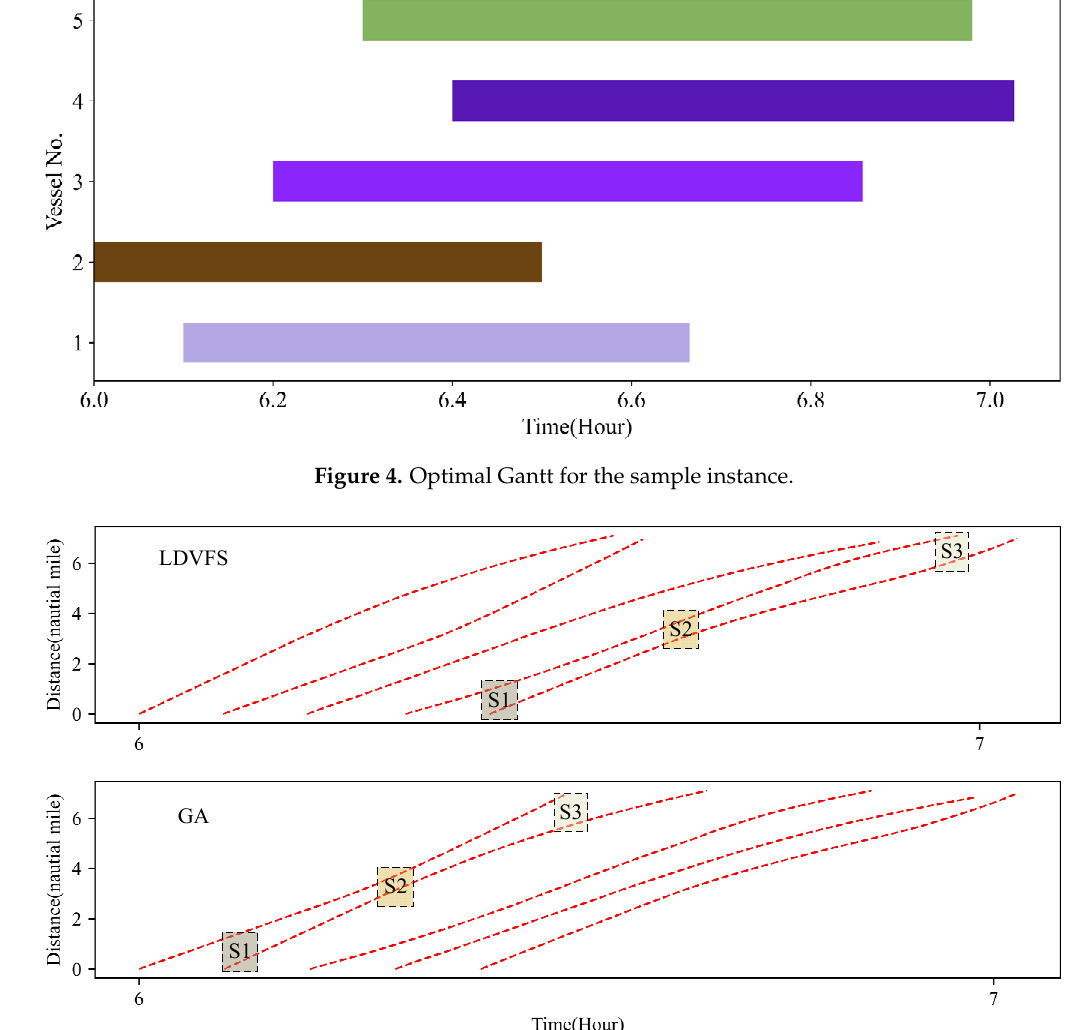
Figure 5. Optimal trajectories for the sample instance.